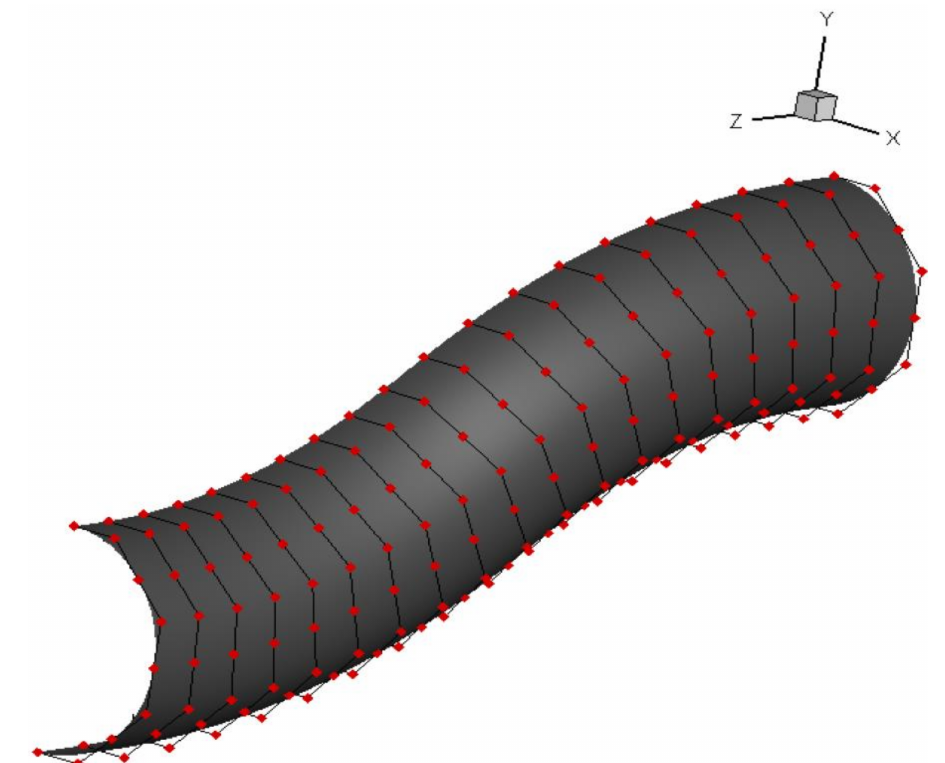
Figure 4. Control net defining the S-duct geometry.